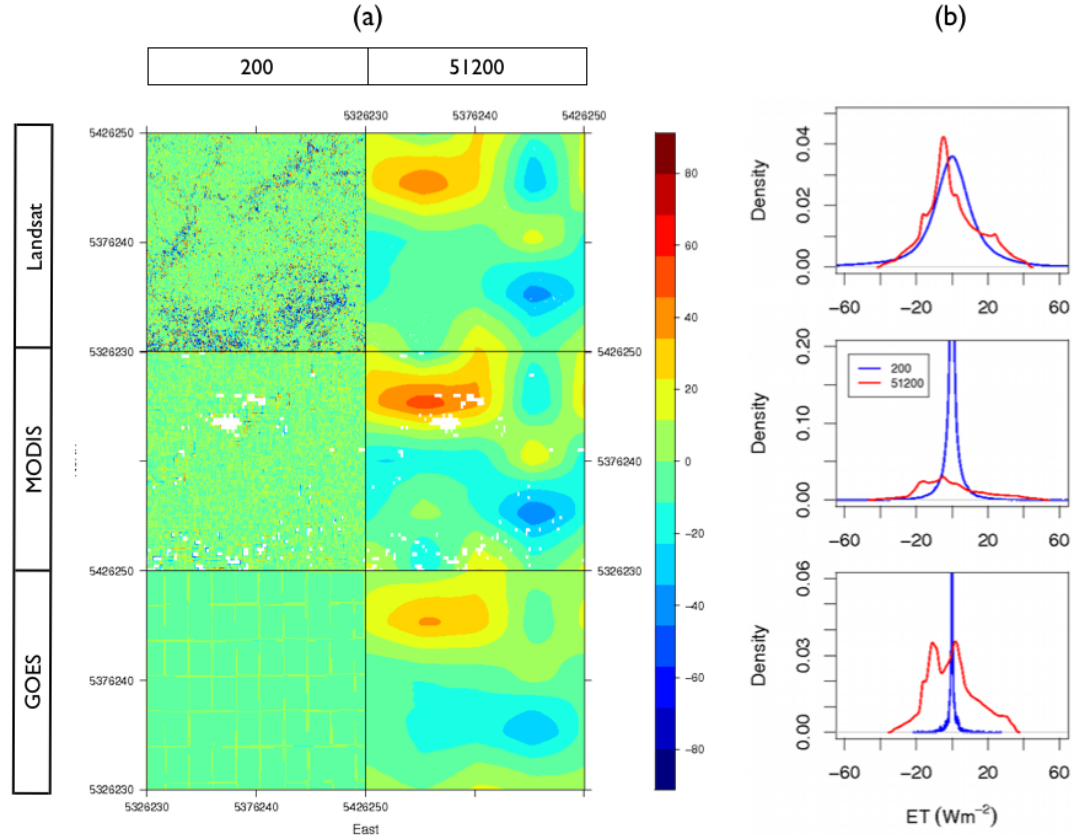
Fig. 4. (a) Example of band pass filtered evapotranspiration [Wm − 2 ] fields for day 181 for (top) Landsat (middle) MODIS and (bottom) GOES at two levels of decomposition (left) 200m and (right) 51200m. Note that values indicate only the flux contributed from the individual scale, not the total evapotranspiration. (b) Shows the associated probability functions for each image in (a)